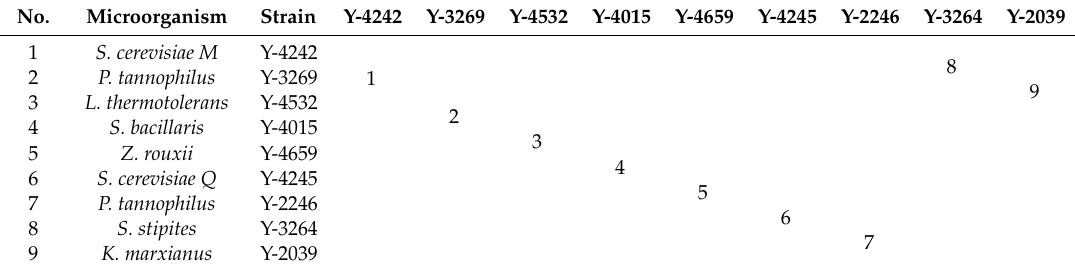
Table 2. Combinations of yeast strains consortia evaluated for their biocompatibility.